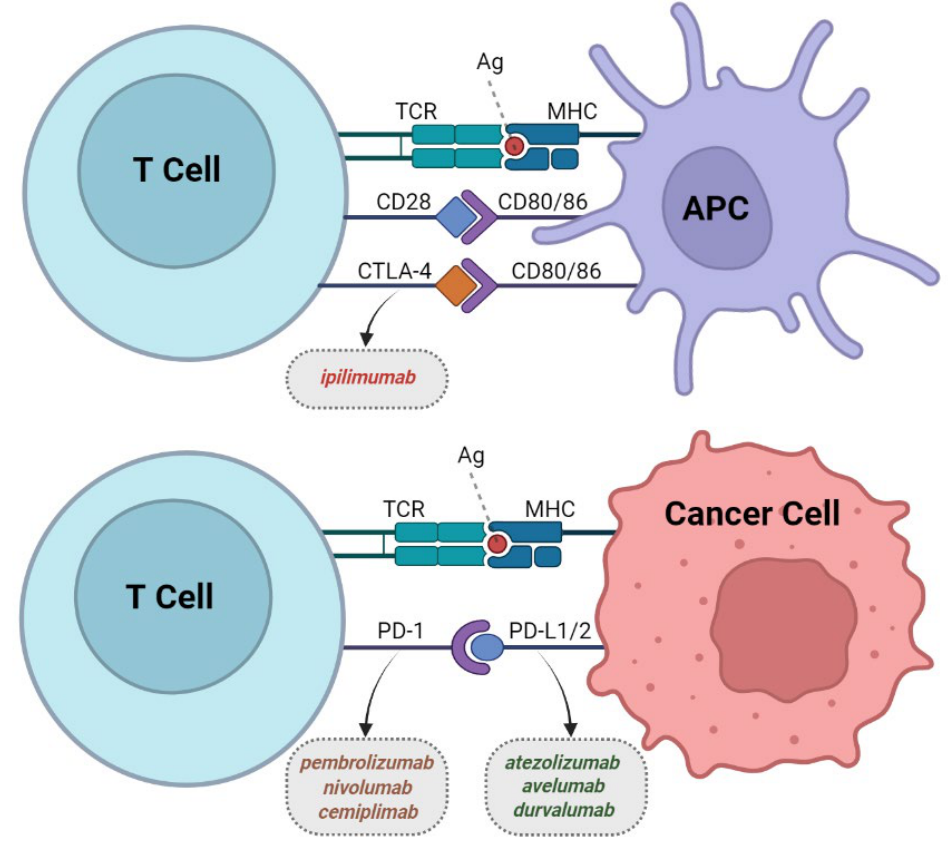
Figure 1. FDA-approved classes of immune checkpoint inhibitors (CPIs). CTLA-4 (through the interaction with its ligands B7-1/CD80 and B7-2/CD86) or PD-1 (via binding to its ligand PD-L1) trigger inhibitory signals to attenuate T-cell immune response. These T-cell receptor targets provide rationale for the use of CPIs such as anti-CTLA-4, PD-1, and PD-L1, which are illustrated with dotted-border boxes to increase immune response and kill tumor cells. CTLA-4: Cytotoxic T-lymphocyte-associated protein 4; PD-1/PD-L1: Programmed cell death protein-1 and its ligand -1, respectively; APC: Antigen-presenting cell; Ag: Antigen; TCR: T-cell receptor; MHC: Major histocompatibility complex. (Figure was designed with BioRender.com, https://help.biorender.com/en/articles/3619405-how-do-i-cite-biorender, accessed on 7 November 2022).